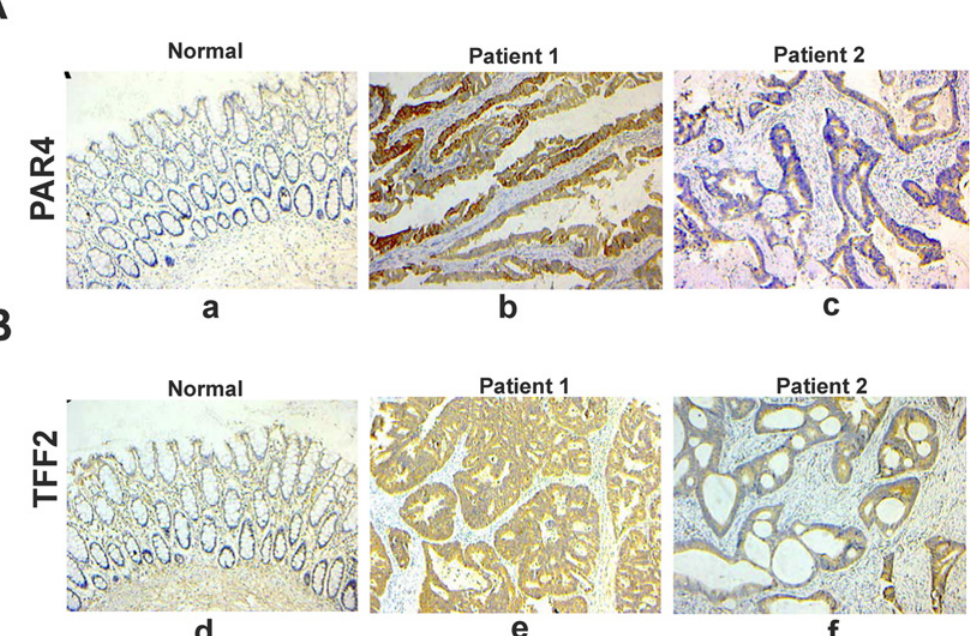
Fig 3. Representative photomicrographs of immunohistochemical staining of PAR4 and TFF2 in paraffin sections of colorectal tissues. (A) immunohistochemical staining for PAR4. (a) normal colorectal mucosa; (b) colorectal cancer tissue of number one patient. (c) colorectal cancer tissue of number two patient; (B) immunohistochemical staining for TFF2. (d) normal colorectal mucosa; (e) colorectal cancer tissue of number one patient; (f) colorectal cancer tissue of number two patient. Bar, 100 μ m for each panel, and 50 μ m for insets.